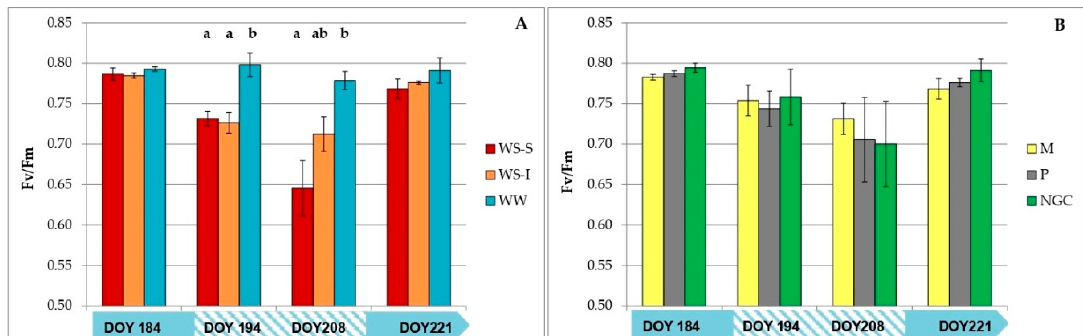
Figure 4. Chlorophyll fluorescence (Fv/Fm) in adult leaves of Pinot noir, subjected to three irrigations protocols: ( A ) WS-S in red, WS-I in orange, and WW in blue. Chlorophyll fluorescence (Fv/Fm) in adult leaves in the three root systems: ( B ) Mgt 101-14 (M) in yellow, 1103 Paulsen (P) in dark grey, and not grafted vines (NGC) in green. The measurements were conducted before (DOY 184), during (DOYs 194 and 208, marked with dashed lines), and after (DOY 221) the water stress trial. The bars indicate the standard error. Different letters indicate significant differences (LSD test, P < 0.05).